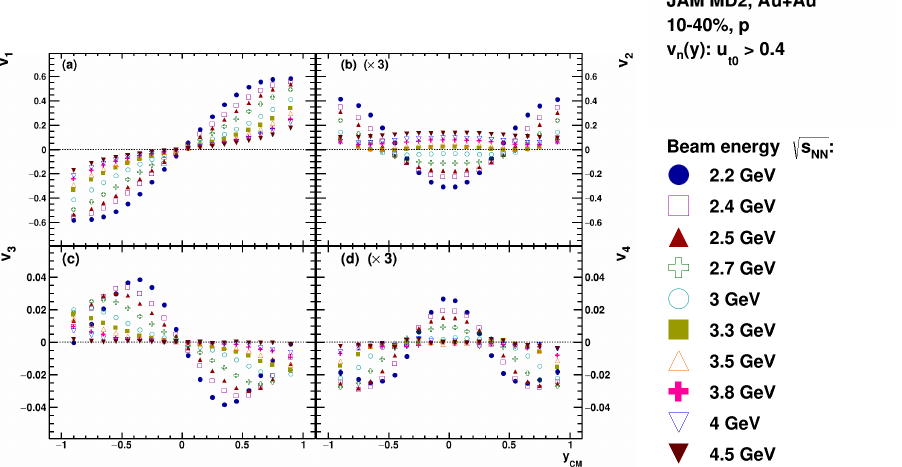
Figure 15. Rapidity ( y cm ) dependence of anisotropic flow coefficients v 1 , v 2 , v 3 and v 4 of protons ( a – d ) in the 10–40% central Au + Au collisions at to the v n ( p T ) results obtained for different beam energies from √ s NN = 4.5 GeV (brown down-pointing triangles) using the JAM model with hard momentum to dependent mean-field MD2 ( K 0 = 380 MeV) EOS.